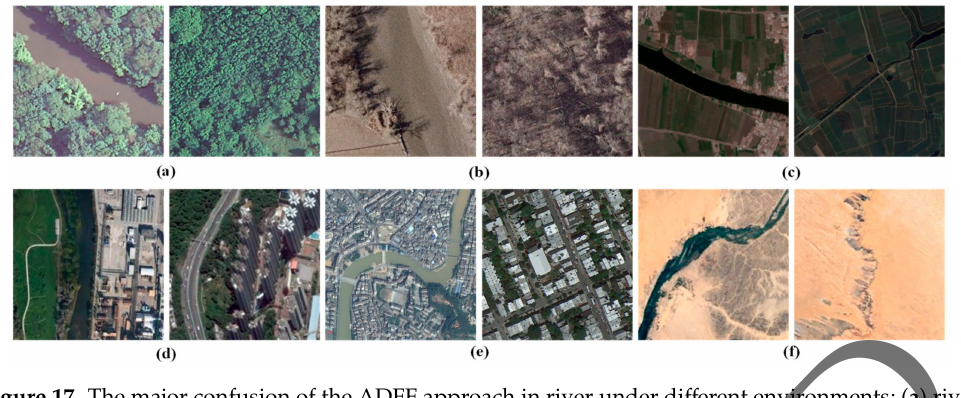
Figure 17. The major confusion of the ADFF approach in river under di ff erent environments; ( a ) river surrounded by forests, ( b ) dried rivers, ( c ) rivers surrounded by farmland, ( d ) rivers near the buildings and meadow, ( e ) rivers across the residential, ( f ) rivers in the